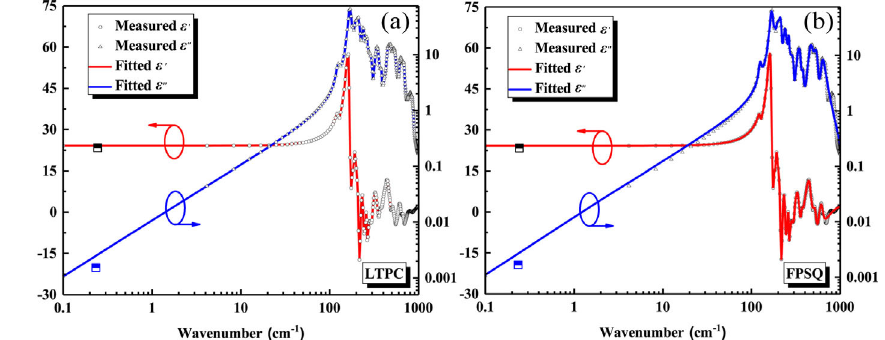
Fig. 7 Real ε′ ( ω ) and imaginary ε″ ( ω ) of relative permittivity after (a) LTPC and (b) FPSQ mode fit. LTPC, Lorentz three parameter semiquantum model; FPSQ, four parameter semiquantum model. Reproduced with permission from Ref. [156], © The American Ceramic Society